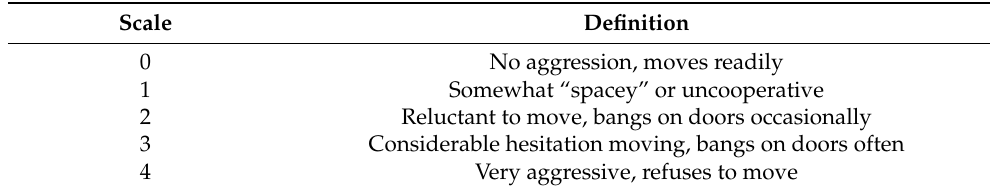
Table 4. Musth behavior scale for Oregon Zoo male elephants.